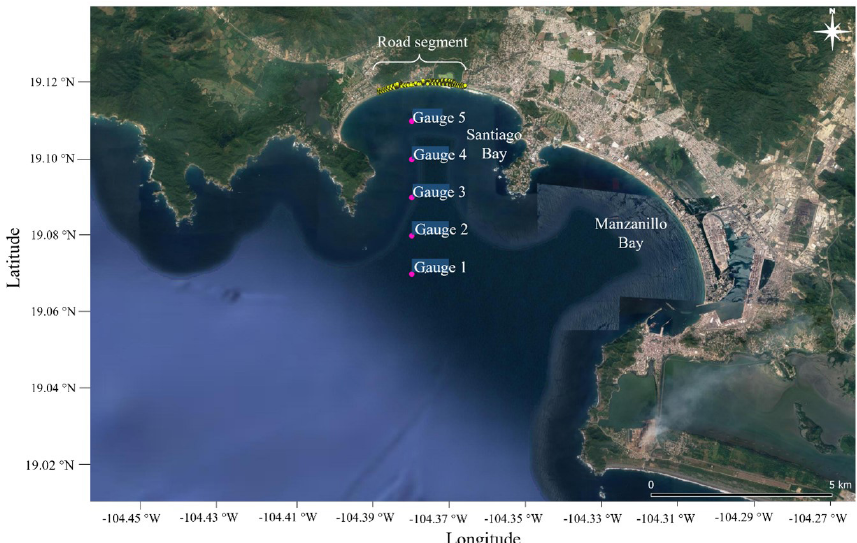
Figure 24. Location of gauges used to obtain the free sea surface elevations and speeds in the simulation (© Google Earth).